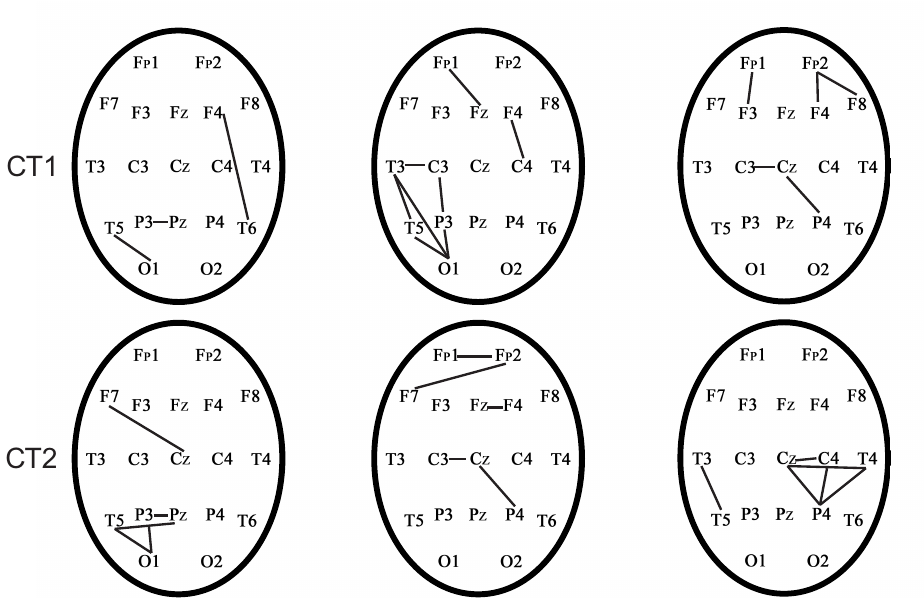
Figure 17. Phase-connected pairs of EEG channels of patients with TBI during the EEG recording in CT1 and CT2 tests.